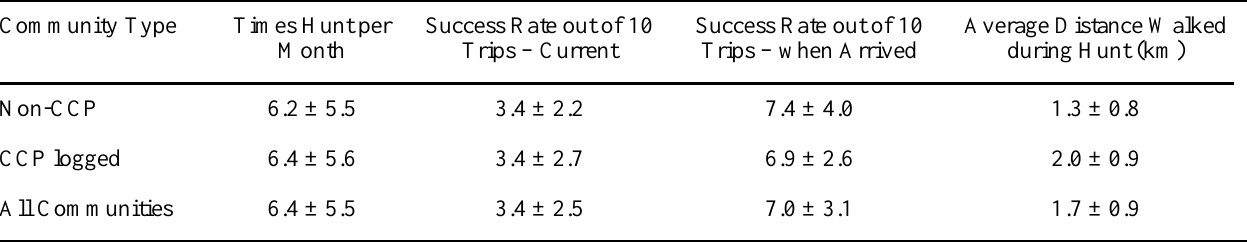
Table 5. Hunting frequency, success rates and distances travelled in CCP-logged and non-CCP communities according to household survey responses. Communities: CCP logged: n = 2; non-CCP: n = 3. Success rate is based on household heads’ estimates of the number of hunting trips out of 10 attempts wherein an animal was caught. Times Hunt and Distance Walked are based on household heads’